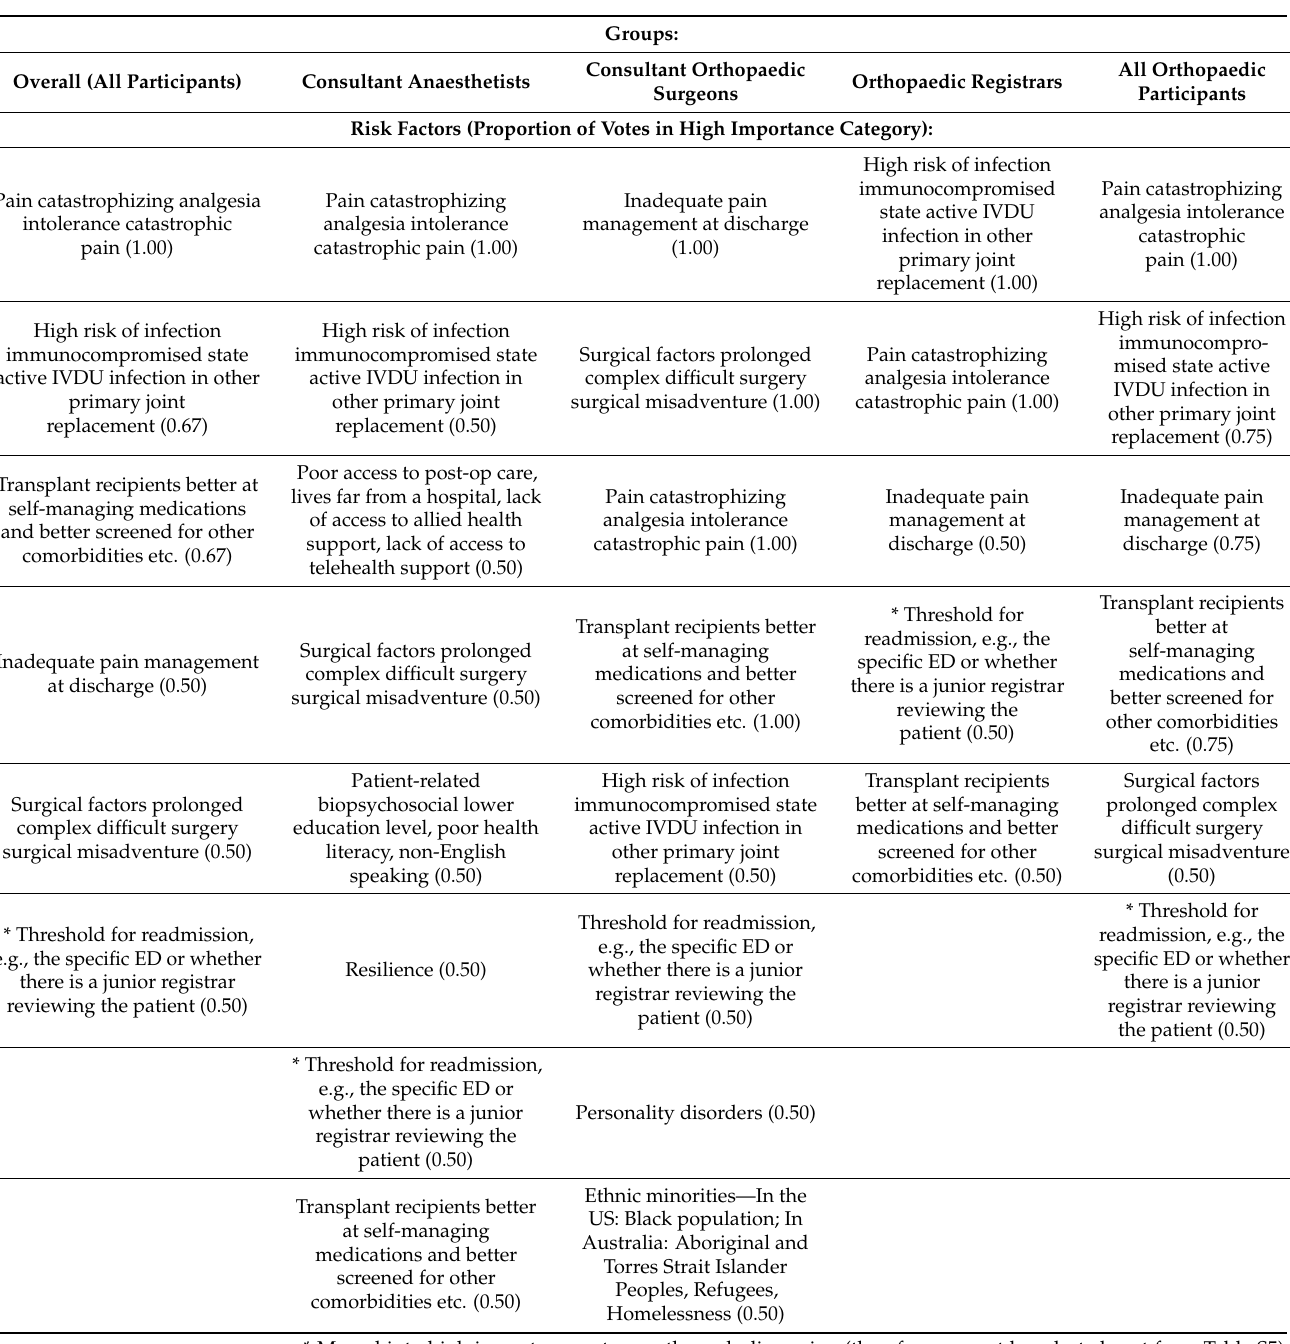
Table 3. Focus group risk factors with a final majority vote of high importance overall and amongst each subgroup (Number in brackets corresponds to proportion high importance